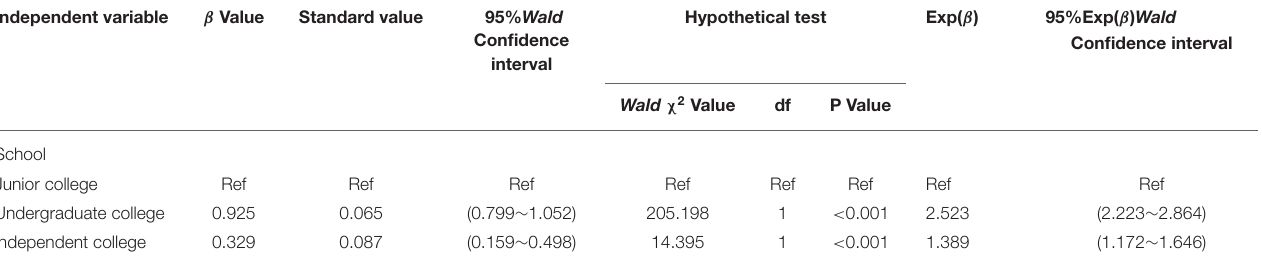
TABLE 2 | Log-binomial regression analysis of total awareness rate of AIDS knowledge among freshmen. Independent